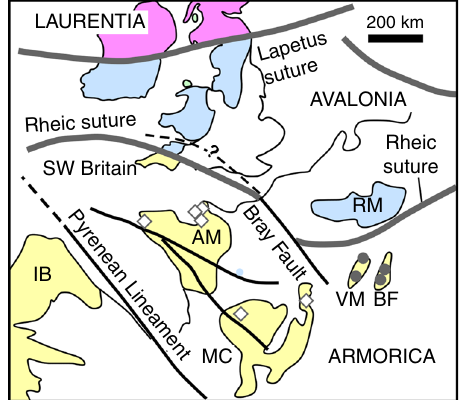
Fig. 5 Location of the newly recognized terrane boundary in its wider tectonic context. Other major faults including the Bray fault and its previously proposed extension (dashed) in Britain 45 . Symbols show locations of the Armorican lamprophyres for which isotopic compositions are shown in Fig. 3 (using the same symbols). Pre-Variscan Massifs: AM Armorican Massif, MC Massif Central, IB Iberia, VM Vosges Mountains, BF Black Forest, RM Rhenish Massif. Map adapted from published tectonic map